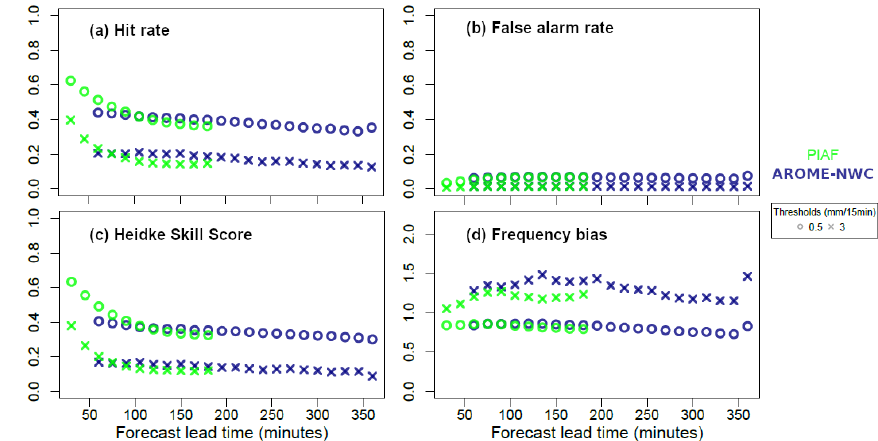
Figure 5. (a) Hit rate, (b) false alarm rate, (c) Heidke skill score, and (d) frequency bias for thresholds: 0.5mm/15min and 3mm/15min computed for AROME-NWC (in blue) and PIAF (in green) over their respective forecast ranges for 15min rain accumulation over the box displayed in Fig.